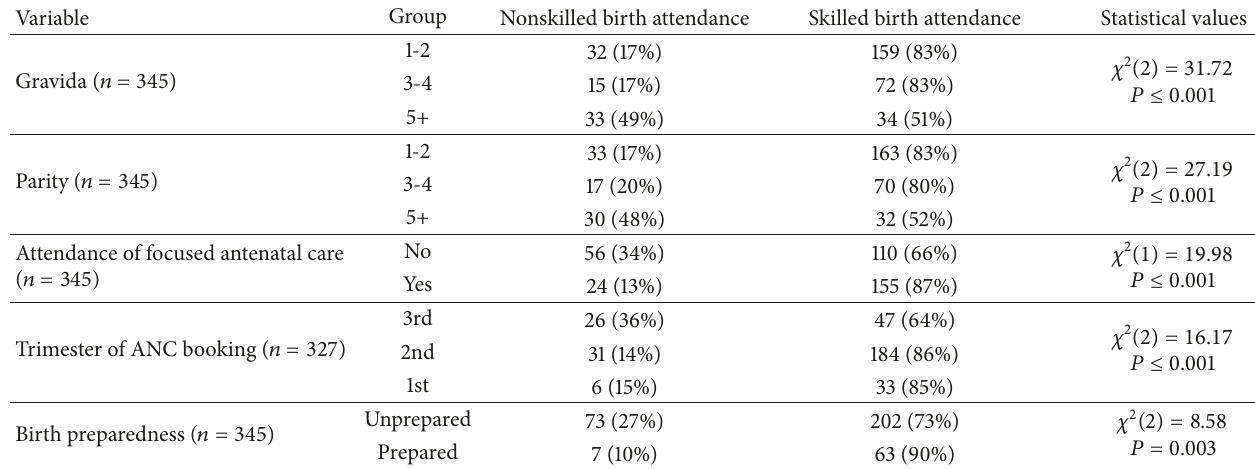
Table 2: Pregnancy related factors associated with skilled birth